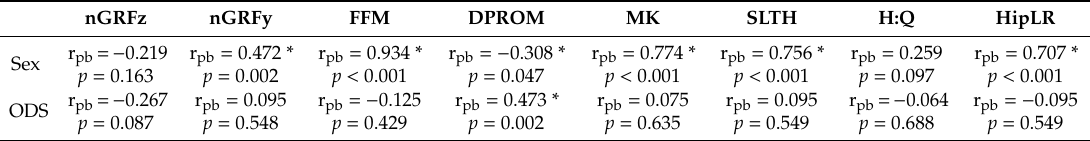
Table 5. Point bi-serial correlations for continuous variables and dichotomous variables.